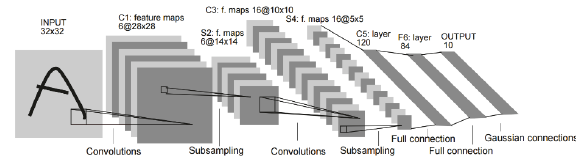
Figure 1: LeNet-5